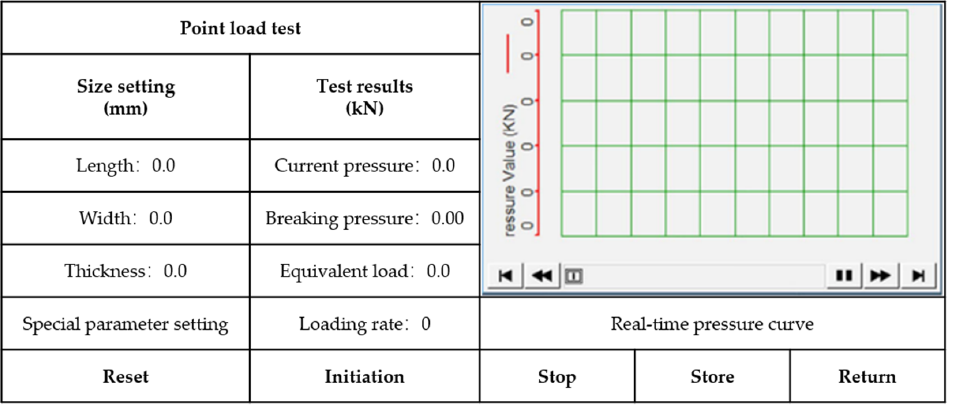
Figure 3. Test—English interface.